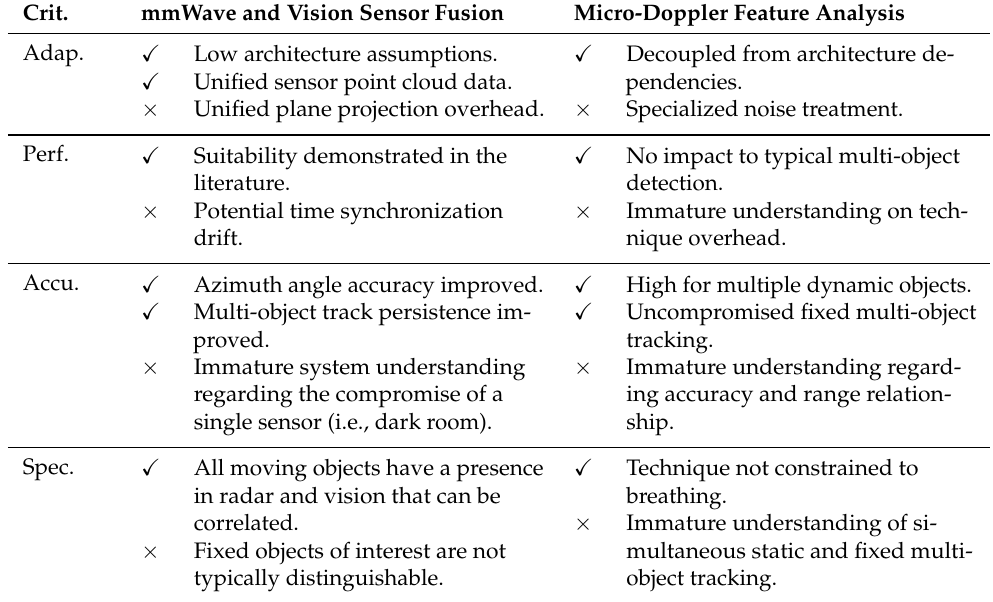
Table 1. A comparison of methodologies explored for the enhancement of object detection in a mmWave tracking